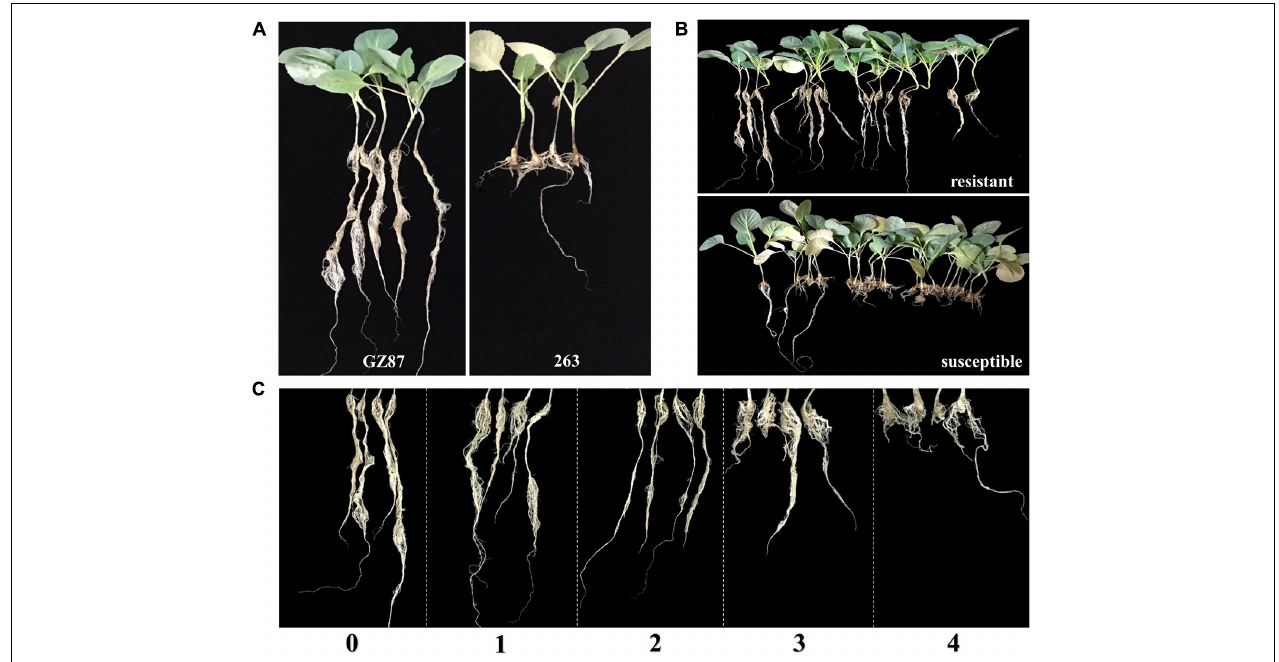
FIGURE 1 | Phenotypes of the Brassica oleracea parents and F2 population. (A) Two cabbage lines, “GZ87” and “263”. (B) The phenotypes of resistant (R) and susceptible (S) plants in the F2 population. (C) The clubroot degree of the F2 population was counted with the scale criterion from 0 to 4. Plants were inoculated with race 4 of Plasmodiophora brassicae